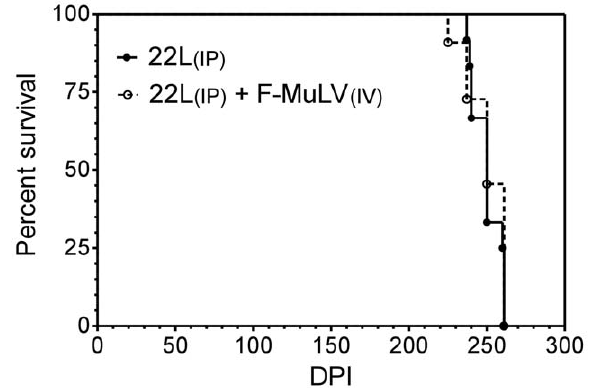
Figure 2. Co-infection of mice with 22L scrapie and F-MuLV does not affect scrapie disease incubation time. Survival curve of (B10 X A.BY)F1 mice inoculated intraperitoneally (i.p.) with 22L mouse scrapie alone (closed circles) or co-infected with 22L scrapie i.p. and FV intravenously (i.v., open circles). dpi=days post-infection.